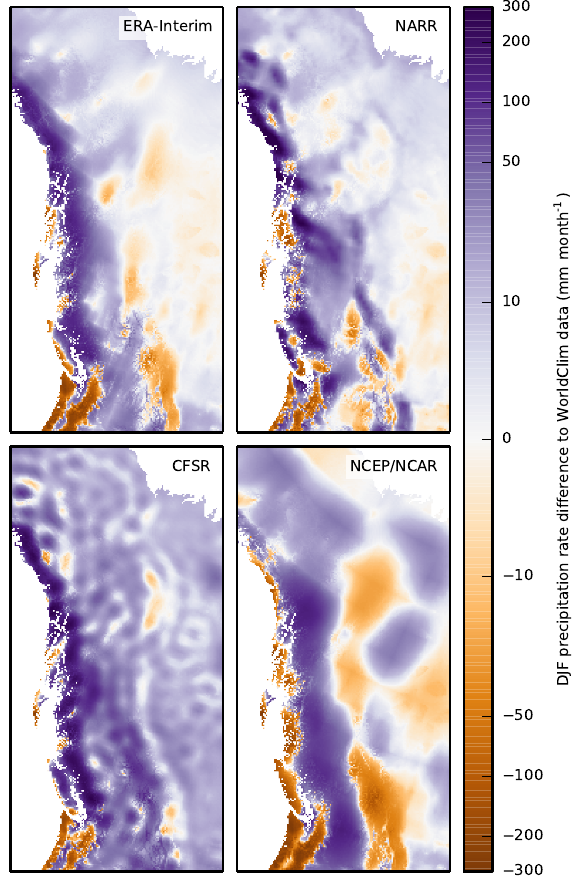
Figure 11. Winter (DJF) precipitation rate difference maps against WorldClim data, after bilinear spatial interpolation. Note the wet bias of all reanalysis data and the large anomalies of CFSR and NCEP/NCAR